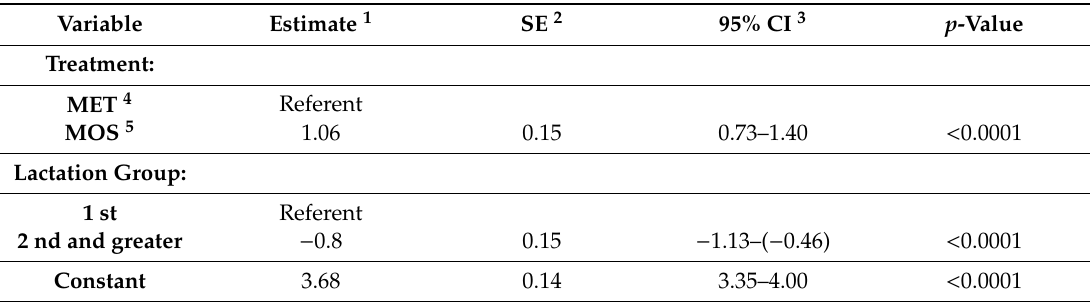
Table 4. Multivariable linear regression comparing log-transformed AUC 0- ∞ (h * µ g / mL) between MET- and MOS-treated